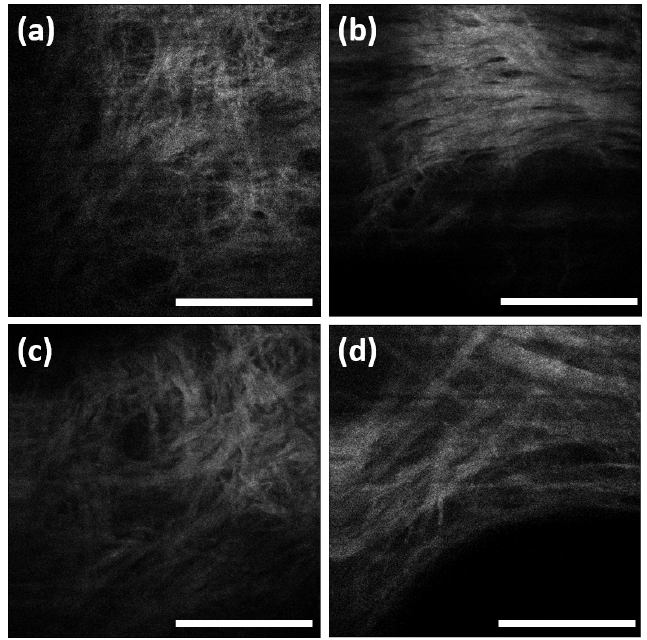
Figure 3. Exemplary images of collagen I structures (SHG signals) of the papillary and reticular dermis. The training data were categorized into group 1 representing thin, convoluted collagen I structures in the papillary dermis ( a ); group 2 representing thick, oriented collagen I structures in the papillary dermis ( b ); group 3 representing thin, convoluted collagen I structures in the reticular dermis ( c ); and group 4 representing thick, oriented collagen I structures in the reticular dermis ( d ). All images were acquired at 50 mW, 760 nm, and a 6.8 s acquisition time. Scale bars are 20 µm in length.